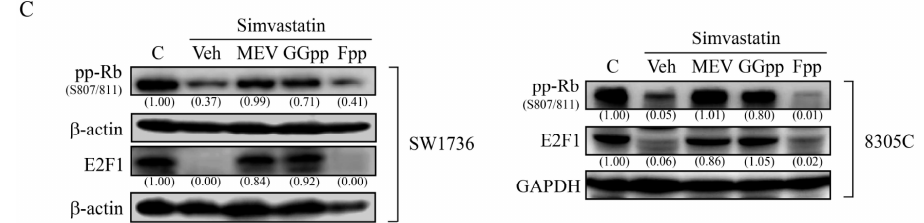
Figure 4. Effects of MEV, GGpp and Fpp on the simvastatin-increased p21 cip and p27 kip expression in ATC cells. ( A ) Simvastatin (10 μ M) increased the mRNA expression level of p21 cip . Values represent the means ± SEM ( n = 3). * p < 0.05, different from corresponding control. Simvastatin increased the protein levels of p21 cip and p27 kip and decreased the protein levels of CCND1 ( B ), hyperphosphorylated-Rb and E2F1 ( C ). These effects were prevented by MEV (50 μ M) or GGpp (20 μ M), but not Fpp (20 μ M). SW1736 and 8305C cells were incubated with simvastatin alone or in the presence of MEV, GGpp or Fpp for 48 h, and then the mRNA and protein levels of p21 cip and p27 kip were quantified and analyzed. GAPDH or β -actin proteins served as control for equivalent loading. Values shown in parentheses represent the quantified results adjusted with corresponding GAPDH or β -actin protein level and expressed as ratio over control. C, control; Veh, simvastatin-incubated group.